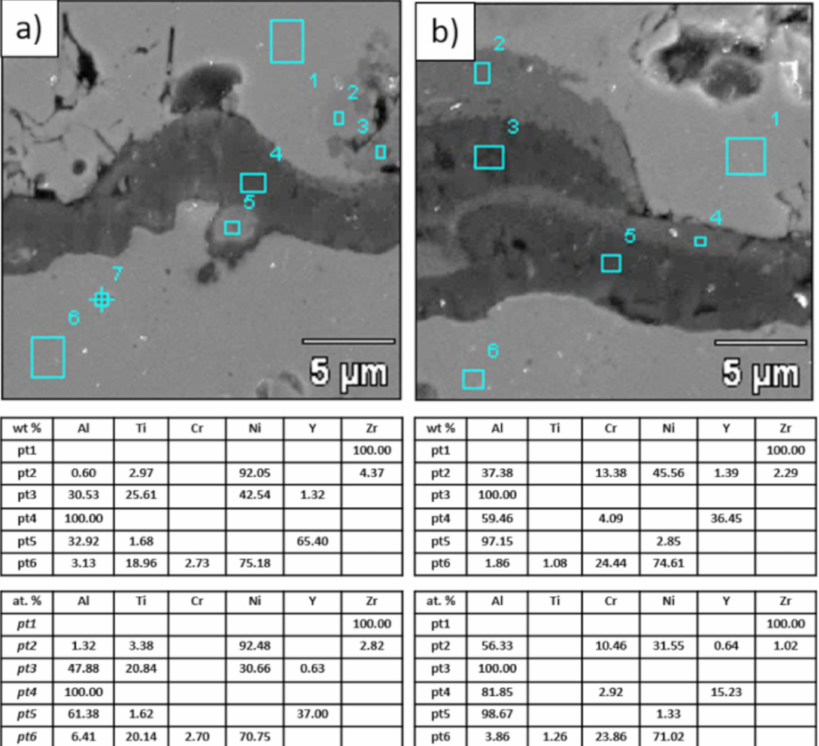
Figure 22. Analysis of chemical composition in micro-areas of TGO zone after 500 h of oxidation at a temperature of 1100 ◦ C—DCL La 2 Zr 2 O 7 / 50% La 2 Zr 2 O 7 + 50% 8YSZ / 8YSZ TBC (SEM): ( a ) zone of the bond-coat bottom and ( b ) zone of the bond-coat